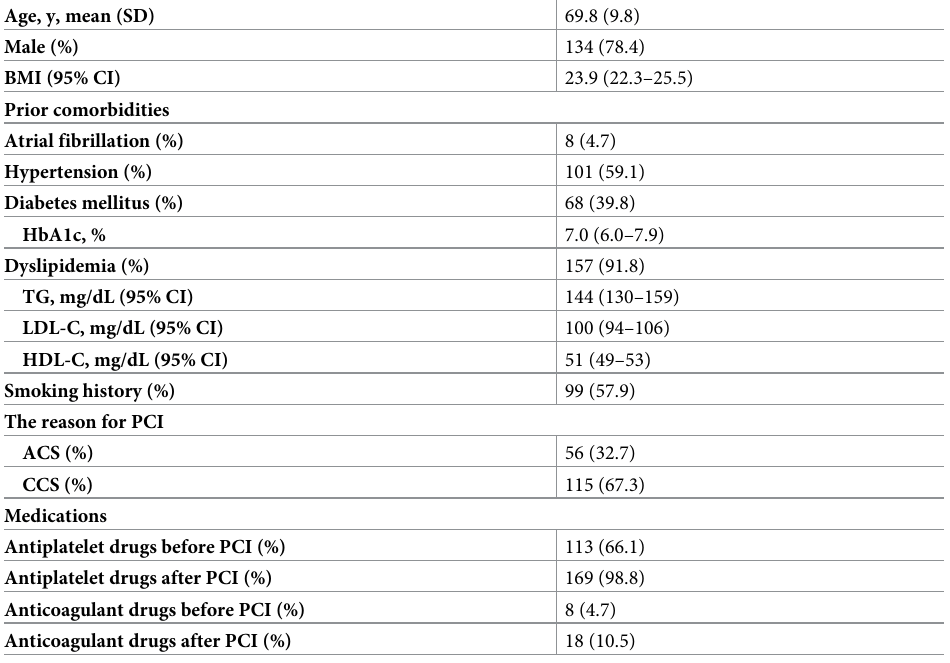
Table 1. Baseline characteristics of the study population.